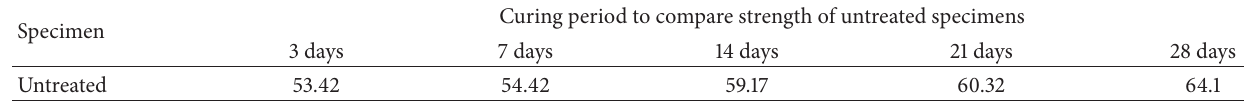
Table 2: Curing period to compare strength of untreated specimens (unit: kPa).